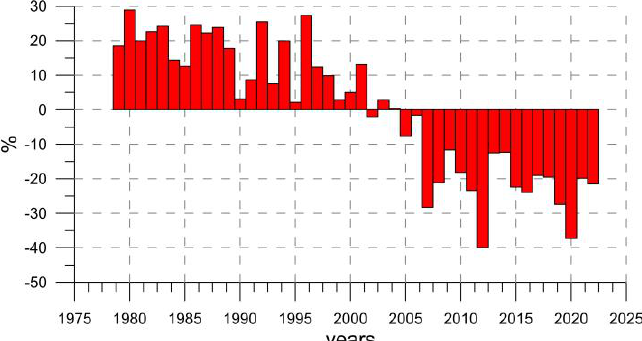
Figure 1. Anomaly of the minimum Arctic Sea ice extent (area where ice concentration exceeds 15%) in September (%) relative to the average for the period of satellite observations (1979–2022), based on the data from [5]. The data for 2022 were taken from the website: http://nsidc.org/arcticseaicenews/ accessed 20 January 2023.